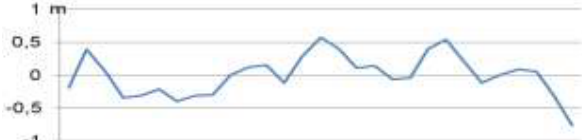
Figure 23. Systematic Z-discrepancies of SPOT-5 HRS DSM as function of Y; profile length =